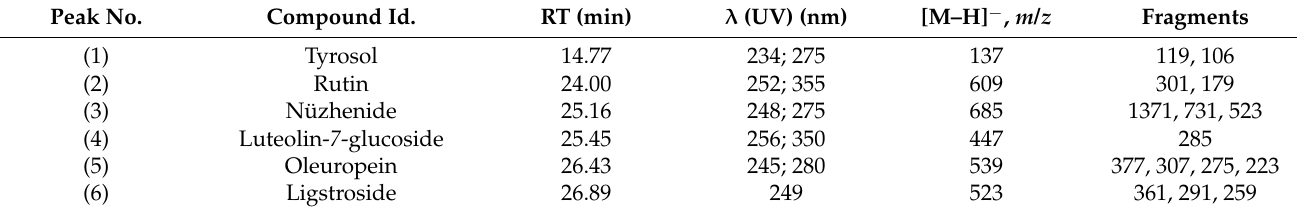
Table 2. Identification of phenolic compounds in olive seeds from different cultivars by HPLC–DAD– MS n in negative